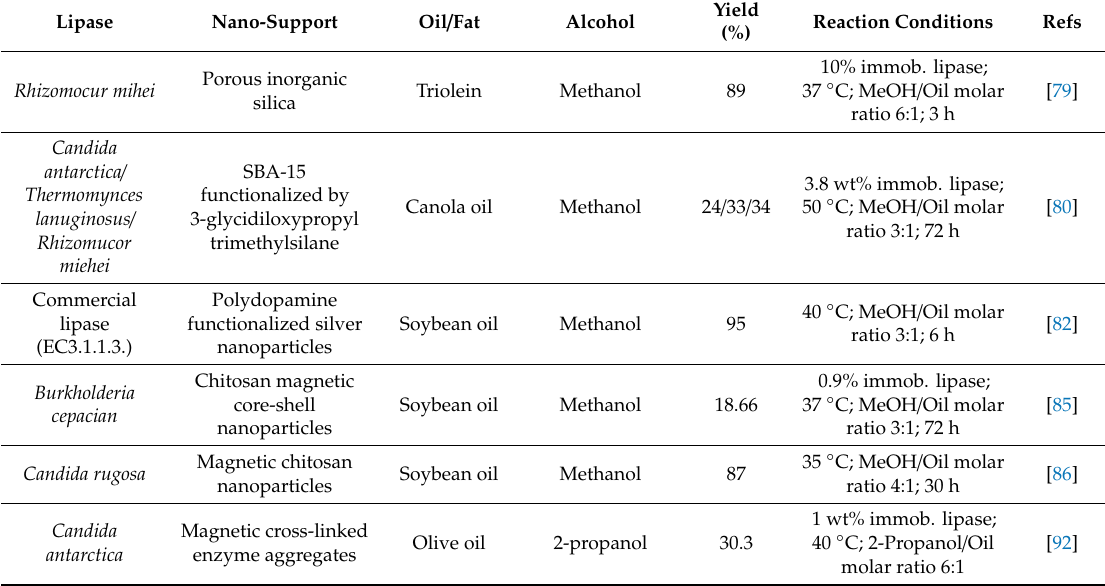
Table 2. Summary for nanobiocatalysts for biodiesel